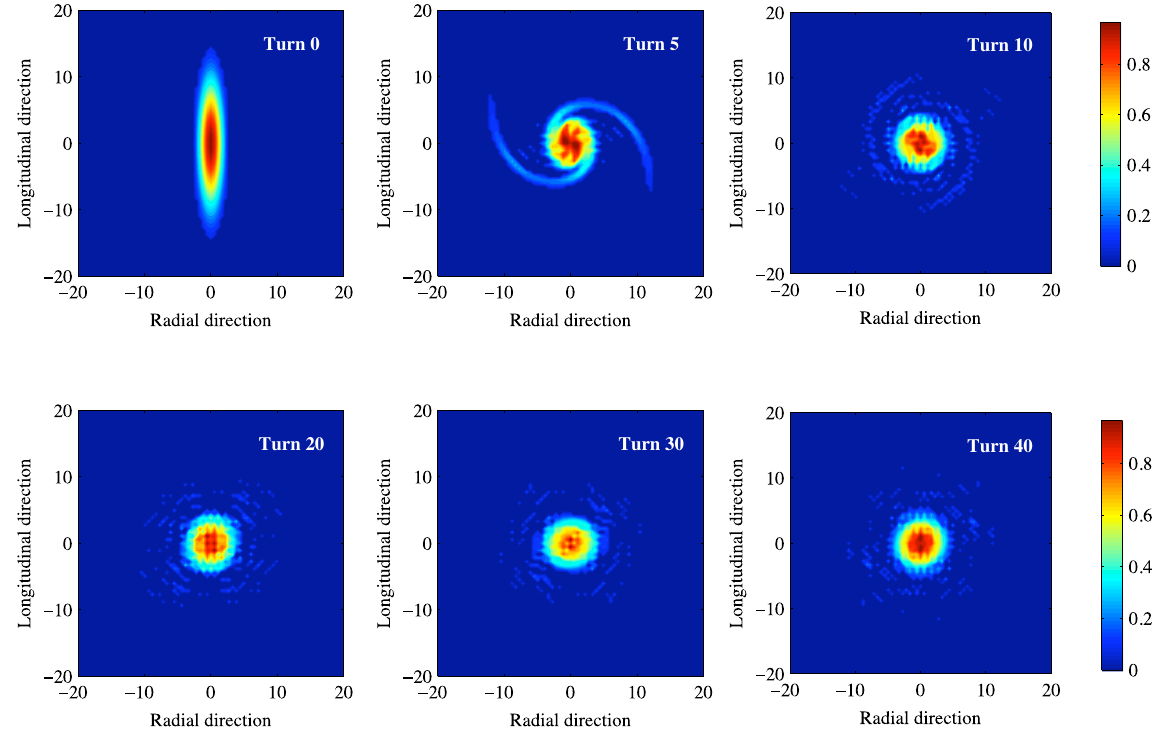
FIG. 7. Top view of an elongated coasting beam in the local frame moving with the beam center. Up: turn 0, 5, 10. Down: turn 20, 30, 40. To compare with figures in Refs. [3,18], the beam’s transport direction is along the negative y direction. (cid:4) 2 ¼ 0 : 8 , 2 (cid:9) x ¼ 2 : 52 mm , and 2 (cid:9) y ¼ 13 : 4 mm